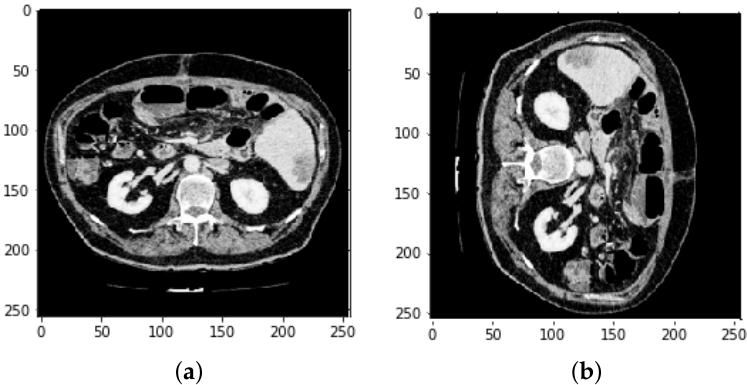
Figure 10. Image slices ( a ) before rotation and ( b ) after rotation by 90 ◦ .